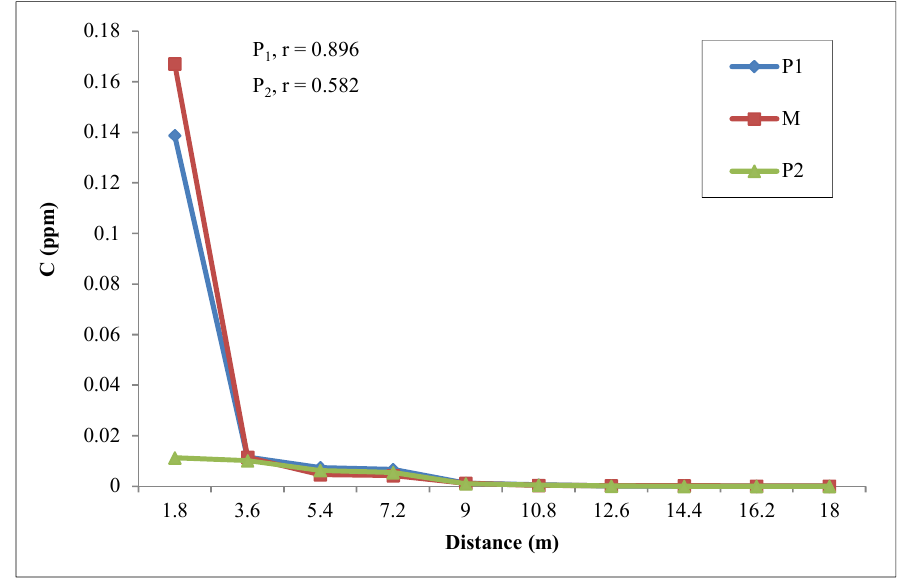
Figure 8. Measured and Predicted Concentrations against Distance for the month of